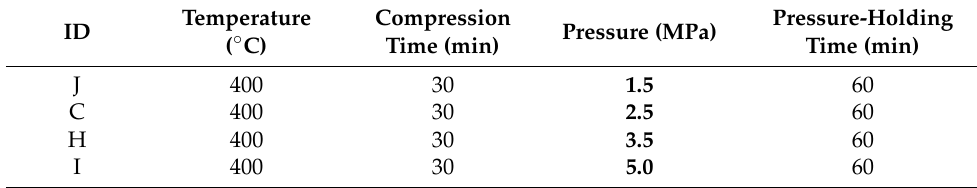
Table 5. Process parameters for different hot compression pressure scenarios.